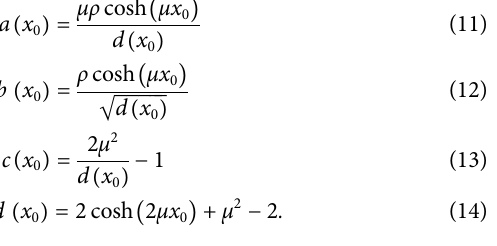
(cid:7)(cid:7) √ 2 , (B) μ (cid:2) 1, (C) μ (cid:2) 1 / 2, and (D) μ (cid:2) 1 /